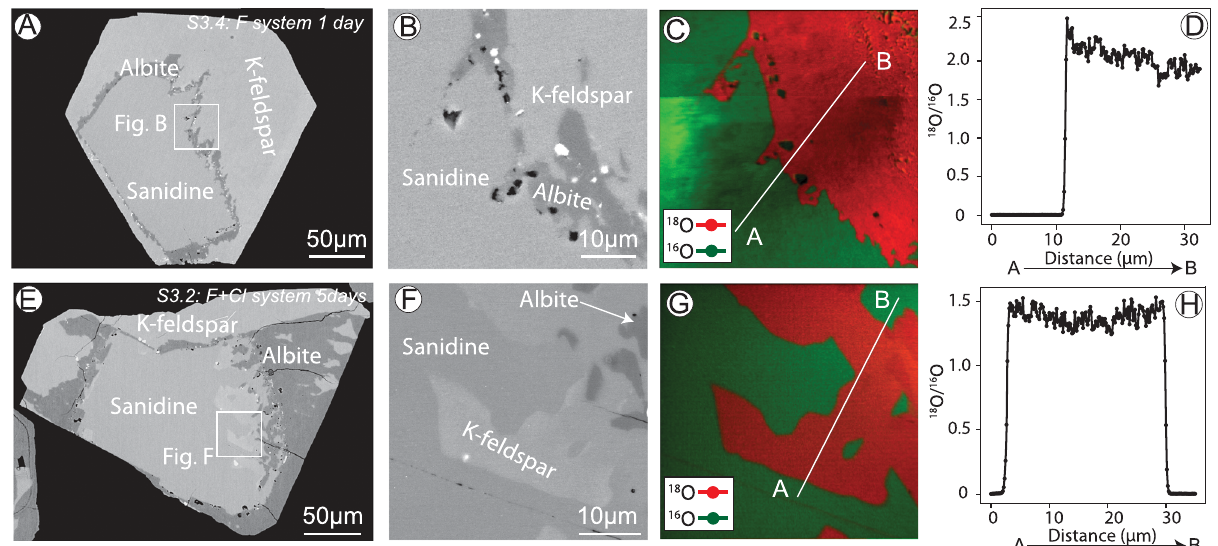
Fig. 5 Nano-SIMS analysis of reactions products formed in 18 O-enriched solutions. Products within 1 day ( A – D ) and 5 days ( E – H ). A , B , E , F BSE images showing the reaction products; ( C , G ) oxygen isotopes maps; ( D , H ) 18 O/ 16 O line pro fi les of locations shown in C , G . Note the brighter fi eld in left side of C is due to charging issues, which result in higher counts of ions detected (Supplementary Fig.